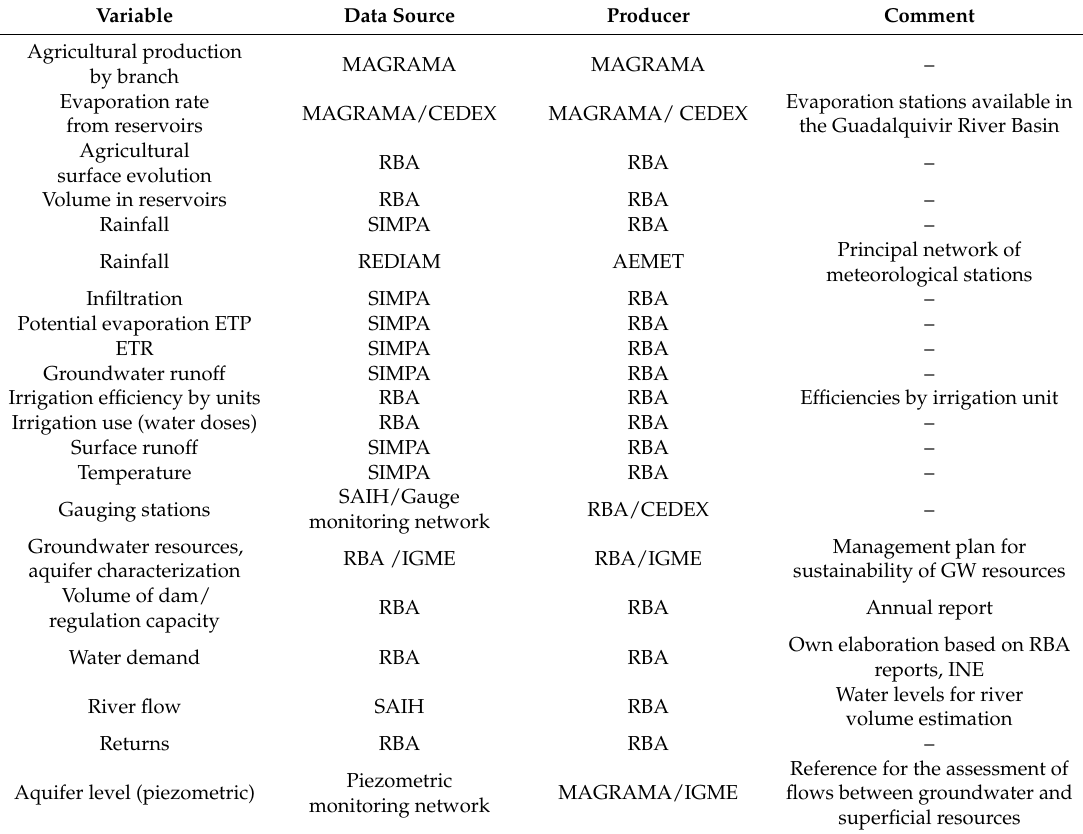
Table 1. Data source for hydrological